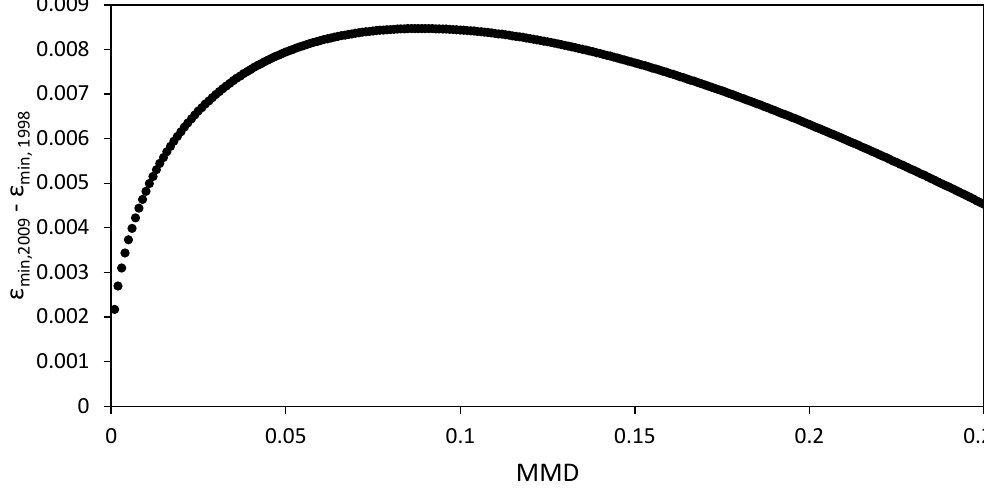
Figure 2. Difference between minimum emissivity retrieved using the empirical expression proposed in [12] and the one proposed in [10] depending on the maximum-minimum difference ( MMD ).